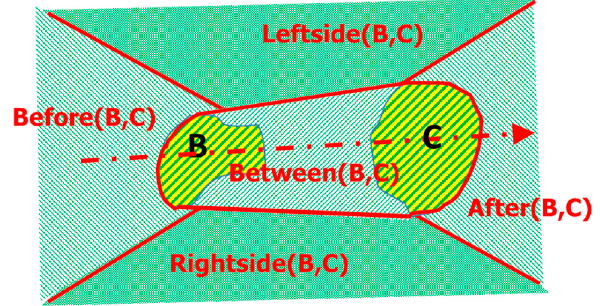
Figure 2. Some representative relations of the 5-intersection model (figure partly taken from [25]).